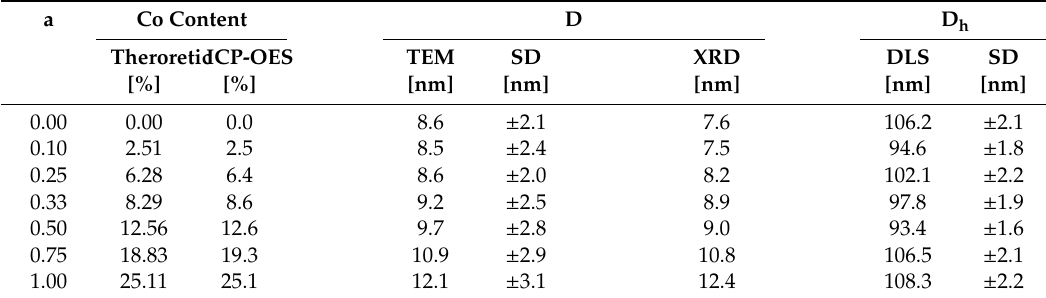
Table 1. Overview on the structural properties of the prepared particles: the Co substitution degree ( a ) during preparation, the expected Co content (theoretically) as well as the measured resulting Co content (inductively coupled plasma optical emission spectrometry (ICP – OES)), the diameter from TEM (TEM) and XRD (XRD) as well as the hydrodynamic diameter (D h ) from dynamic light scattering (DLS); SD = standard deviation.